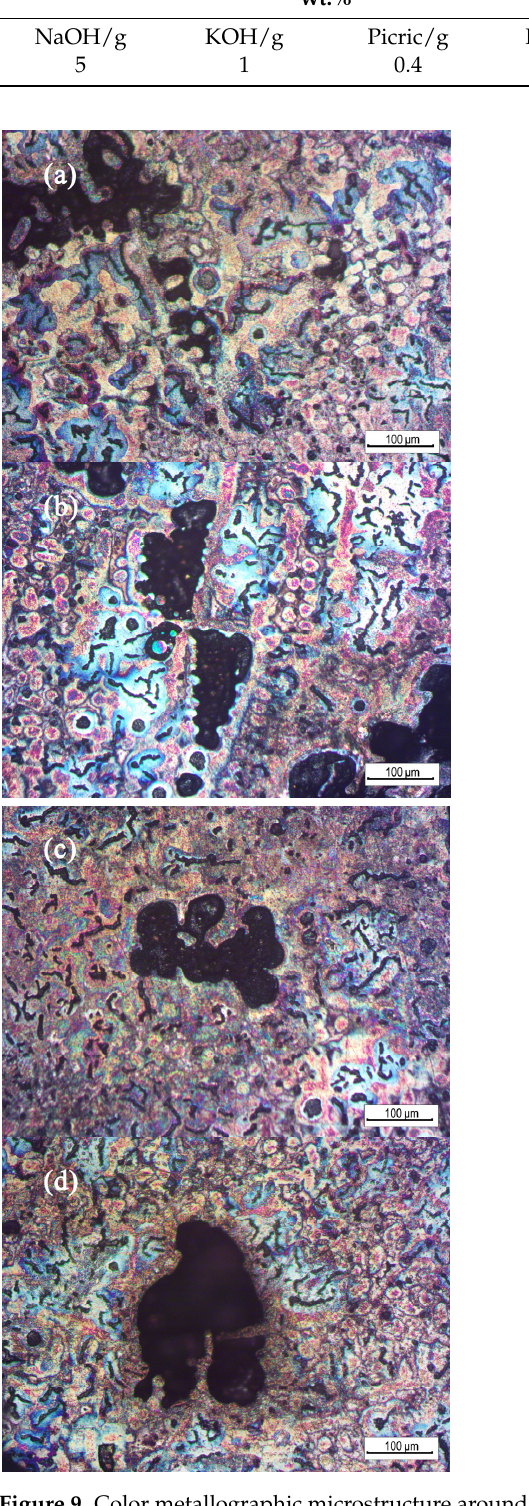
Figure 9. Color metallographic microstructure around the shrinkage: ( a , b ) shrinkage in the dendritic gap and ( c , d ) shrinkage in the final solidification zone.